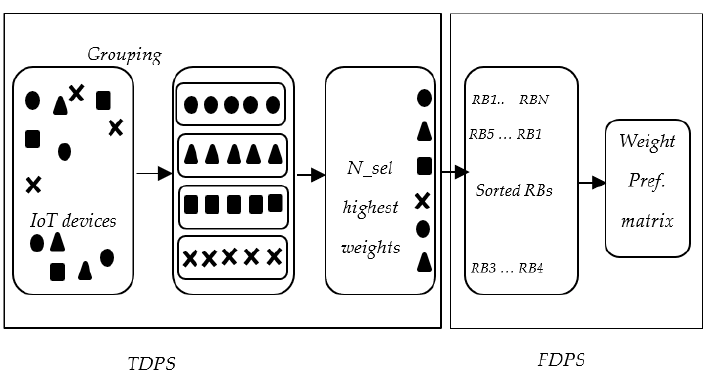
Figure 4. Illustration of the proposed scheduler.